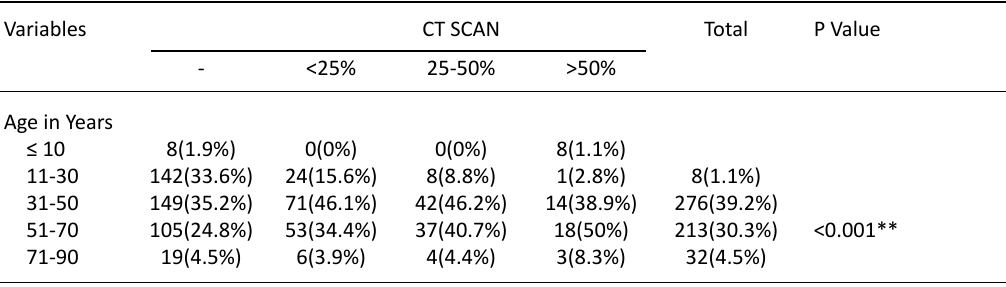
Table 6. Comparison of C- Reactive protein and Computerised Tomography of lung changes in COVID-19 Variables